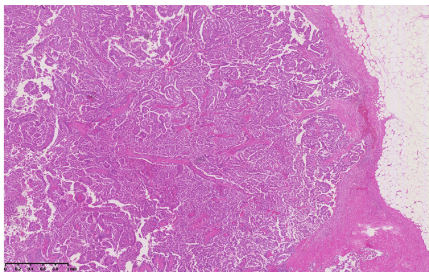
Figure 2: Encapsulated papillary carcinoma showing classical pap- illary architecture with surrounding fibrous